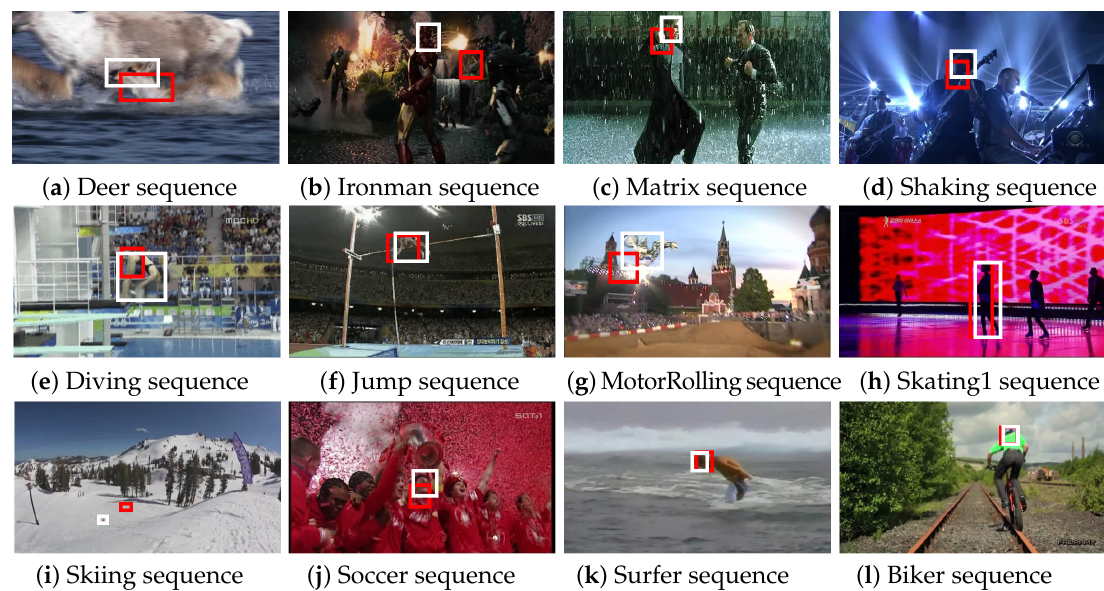
Figure 7. Qualitative comparisons. White boxes present the estimated bounding boxes of our method, while red boxes represent the results of our method without Wang–Landau sampling.